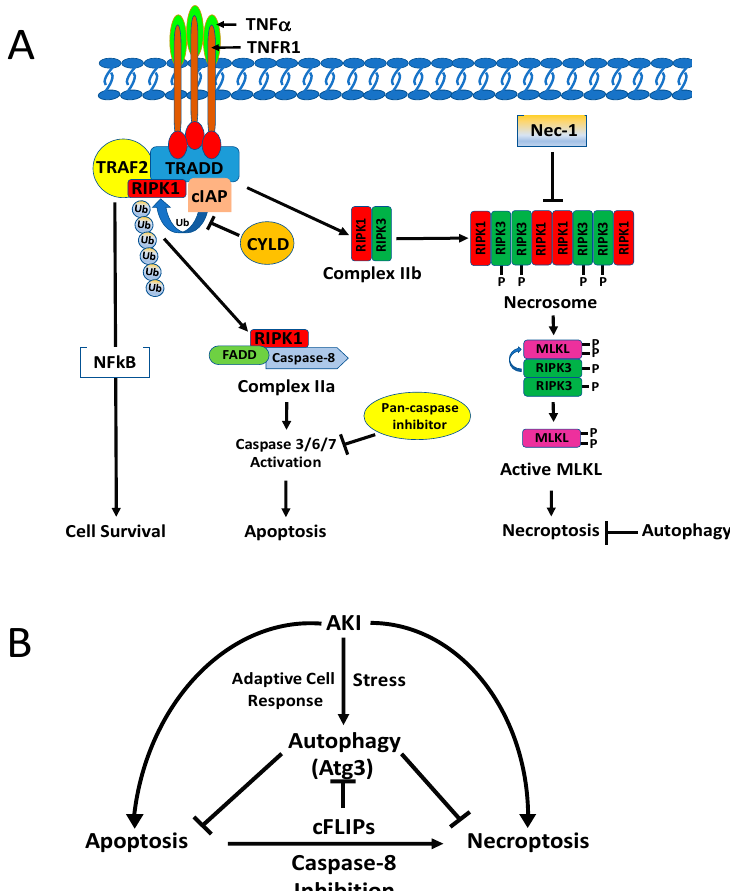
Figure 3. ( A ) Binding of tumor necrosis factor α (TNF α ) with TNF receptor activates the receptor, which recruits TNFR1-associated death domain protein (TRADD). TRADD can recruit several binding partners, including shown in Table 2. Receptor-interacting serine / threonine-protein kinase 1 (RIPK1) and inhibitor of apoptosis proteins (cIAP) are involved in di ff erent downstream signaling pathways, including NF- κ B activation, apoptosis, and necroptosis. TNFR-associated factor 2 (TRAF 2) binds to its cytoplasmic death domain. TRADD has several protein-binding partners and participates in di ff erent signaling pathways, including NF- κ B, apoptosis, necrosis, and mitogen-activated protein (MAP) kinase activation. The N-terminal domain of TRADD interacts with the C-terminal domain of TRAF2 and recruits TRAF2 to TNFR1 for activation of the NF- κ B pathway. E3 ubiquitin ligases cIAP1 / cIAP2 polyubiquitinate (Ub–Ub) RIP1 that promotes the recruitment of inhibitor of nuclear factor kappa-B kinase (IKK) complex and TAK1, for NF- κ B activation. In the absence of cIAP1 or deubiquitination of RIPK1 by cylindromatosis (CYLD), a K63-specific deubiquitinating enzyme (DUB) mediates the deubiquitination of RIP1 to facilitate the formation of complex II (IIa and Iib), which is dissociated from the receptor when TNFR is internalized. cFLIP, RIP1, FADD, and caspase-8 form cytosolic complex IIa to activate the caspase cascade and induce apoptosis. Active caspase 8 also cleaves and inactivates RIPK1 and RIPK2. When a caspase-8 activity is compromised by cFLIPs, vFLIP, or zVAD fmk, RIPK1 interacts with RIPK3 in a “necrosome” complex. RIP3 upon activation phosphorylates MLKL, and this promotes oligomerization of MLKL, resulting in its insertion in the plasma membrane to execute necroptosis. ( B ) Molecular interactions between necroptosis and autophagy show the involvement of cellular FLICE (FADD-like IL-1 β converting enzyme) inhibitory protein (cFLIP), caspase-8, and Atg3. cFLIPs promotes necrosome assembly and subsequent necroptosis by inhibiting caspase-8; cFLIPL prevents its assembly by activation of caspase 8 that cleave RIP1 in the complex. cFLIPL can suppress autophagy by preventing Atg3 from converting LC3 to LC3-II.